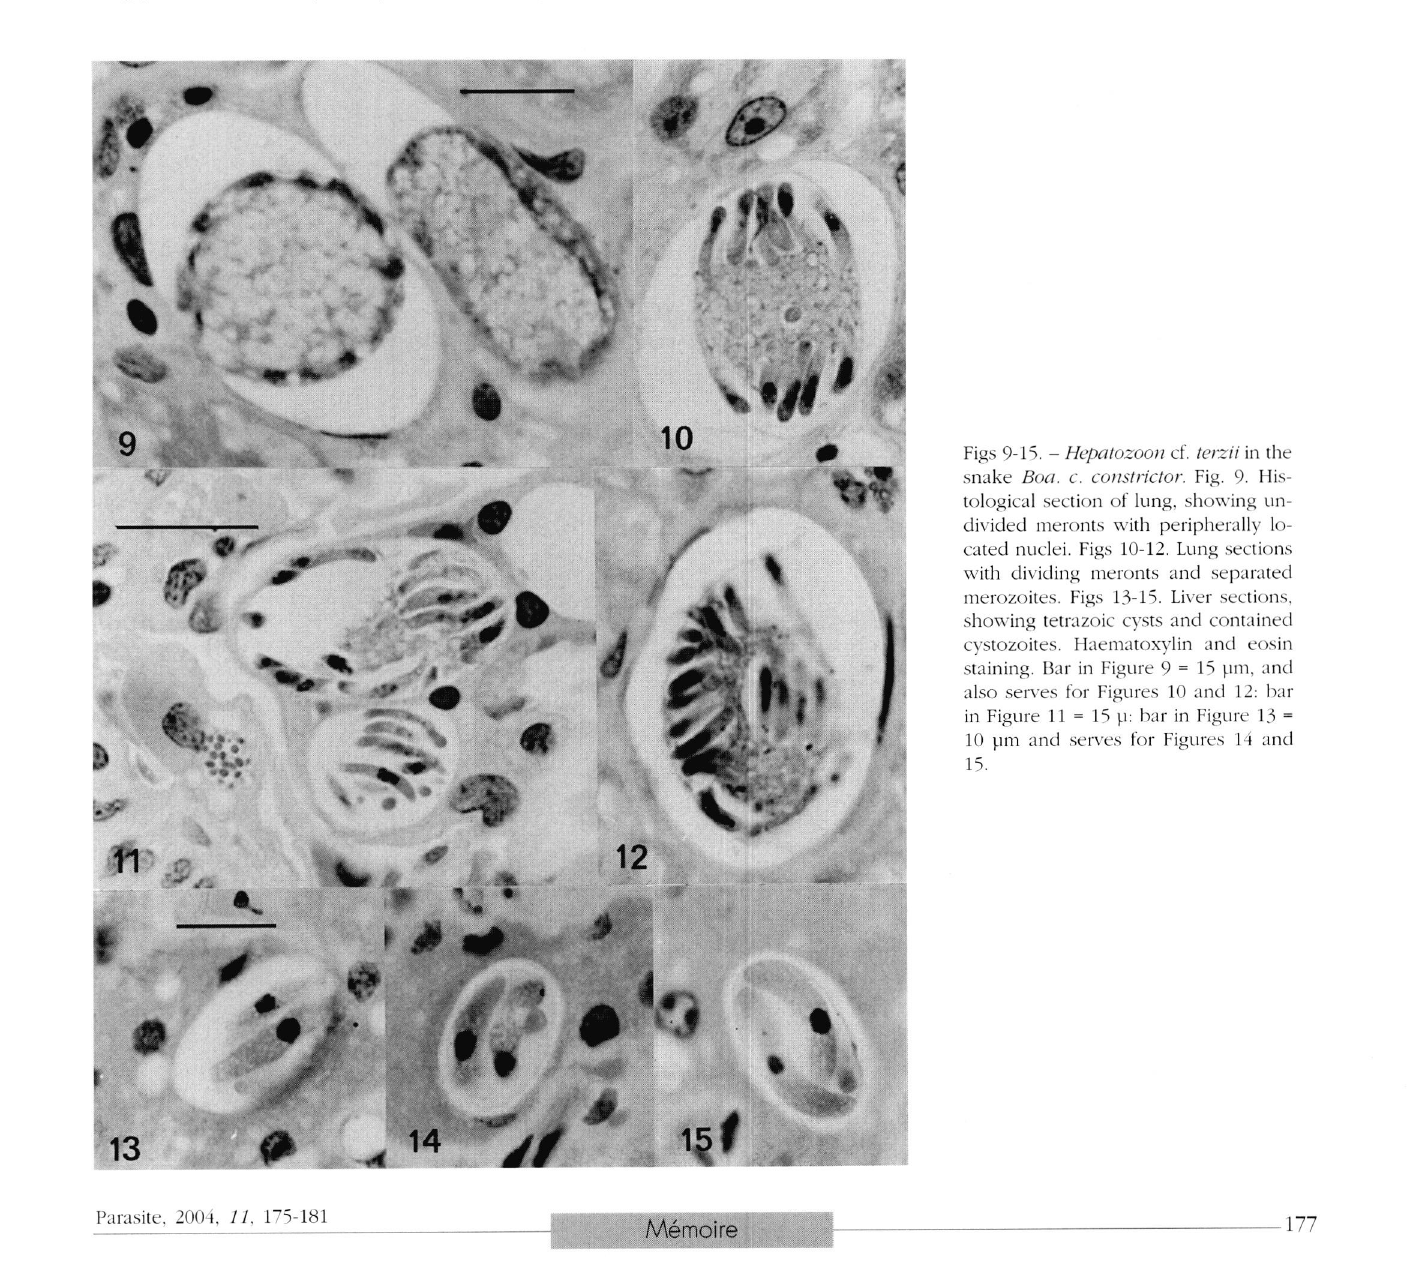
Figs 9-15. - Hepatozoon cf. terzii in the snake Boa. c. constrictor. Fig. 9. His tological section of lung, showing un divided meronts with peripherally lo cated nuclei. Figs 10-12. Lung sections with dividing meronts and separated merozoites. Figs 13-15. Liver sections, showing tetrazoic cysts and contained cystozoites. Haematoxylin and eosin staining. Bar in Figure 9 = 15 µm.